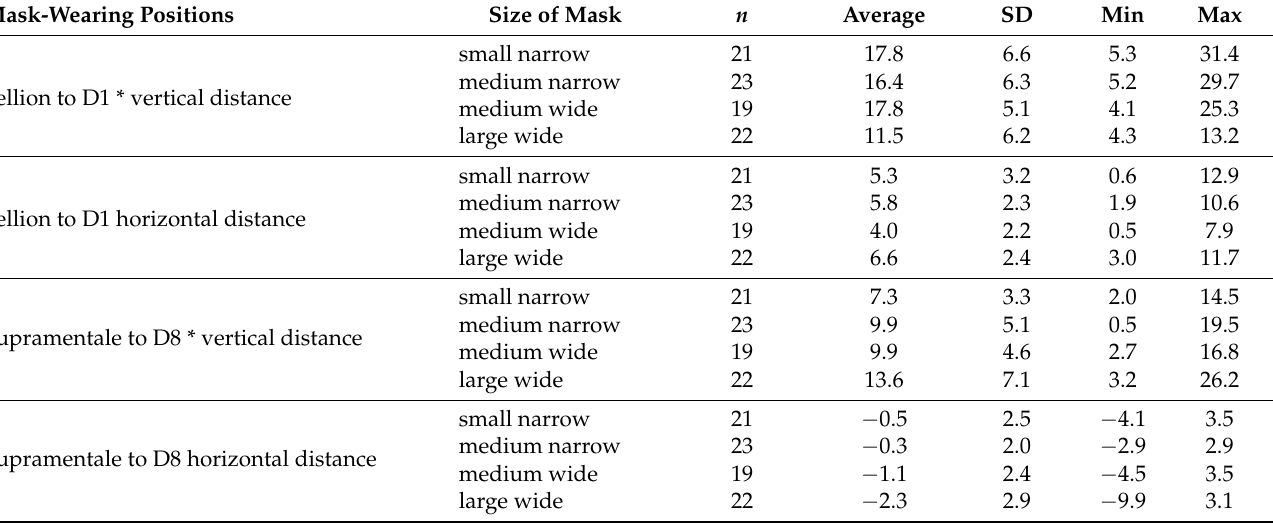
Table 1. Mask-wearing positions (unit: mm) for four mask size categories.